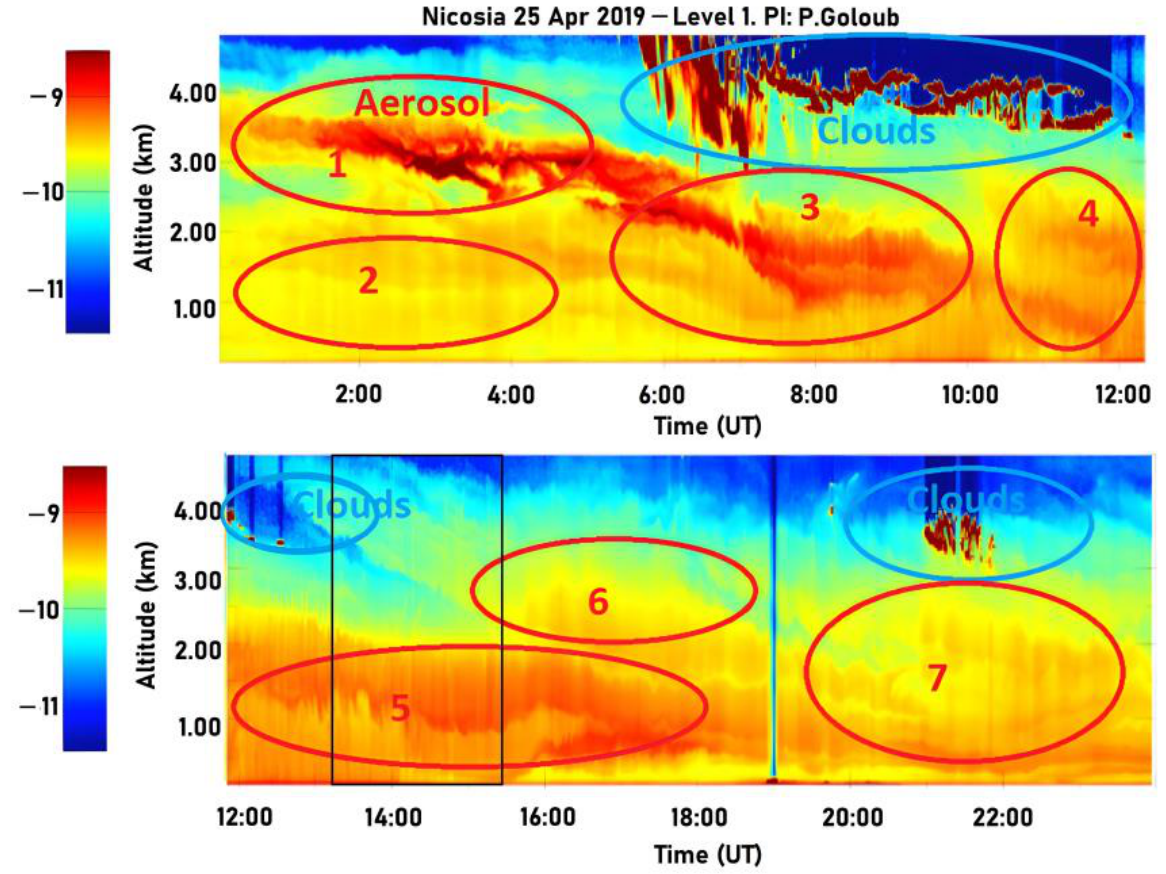
Figure 8. Lidar time series of range-corrected backscatter signal (in arbitrary unit) for Nicosia, Cyprus, 25 April 2019. Blue circles indicate the clouds, and red circles and numbers (1–7) mark the aerosol layers.